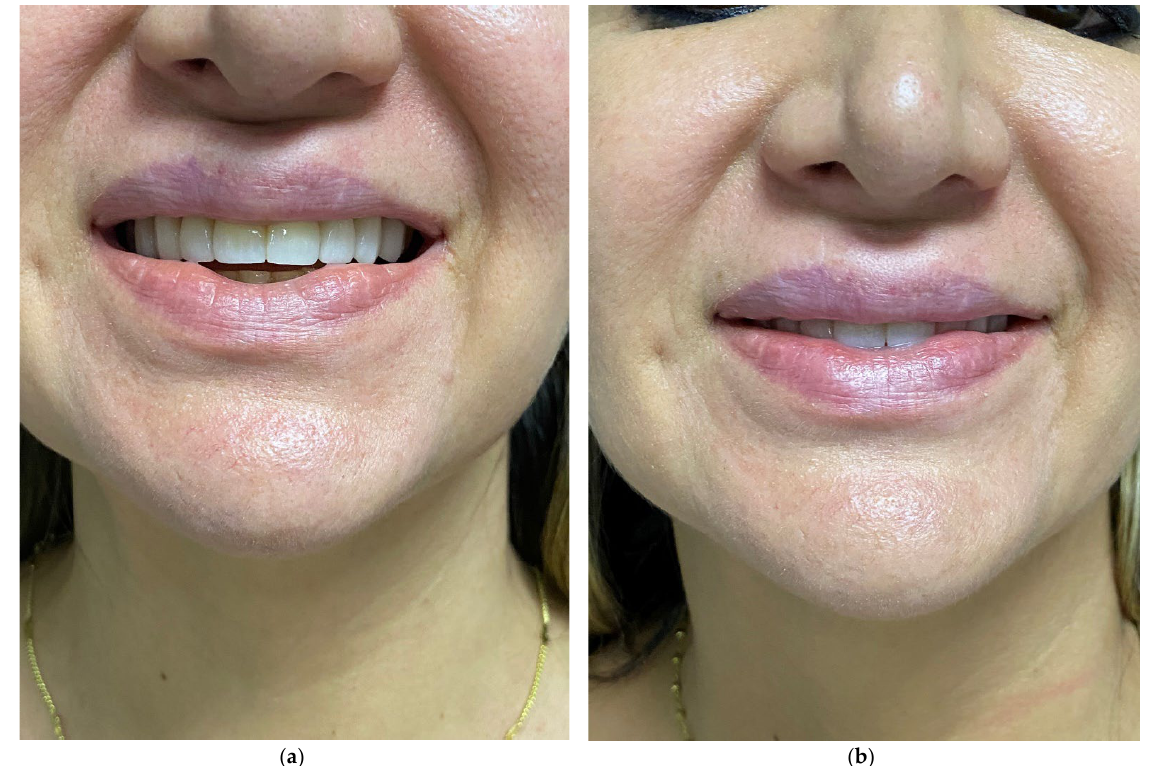
Figure 3. PMMA intralesional laser removal ( a ) and after HAF injection in the central portion of lower lip to correct irregularity ( b ).